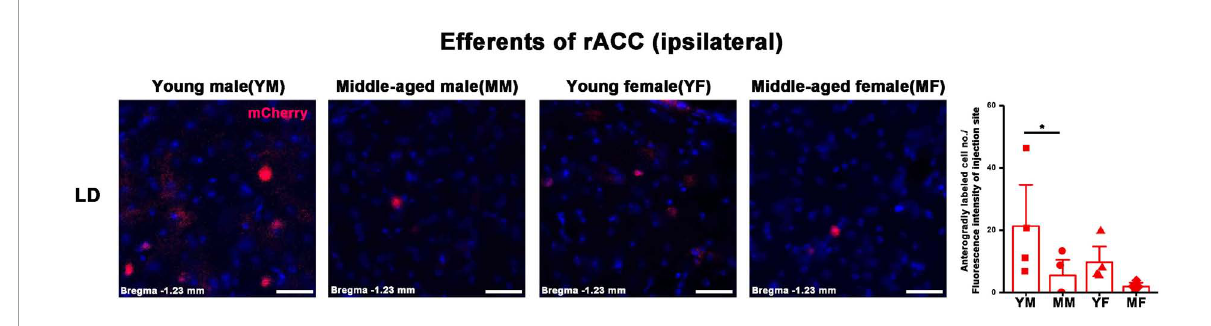
FIGURE7 Ipsilateral brain regions with anterograde projections of the rACC in mice of different ages and sexes. Left: Representative images of anterogradely labeled neurons in the LD regions of young male, middle-aged male, young female, and middle-aged female mice. Right: Anterogradely labeled cell number divided by fluorescence intensity of injection site ( n = 4 young males, n = 4 middle-aged males, n = 4 young females, n = 4 middle-aged females). * p < 0.05. Scale bar = 20 µ m. Error bars represent s.e.m.